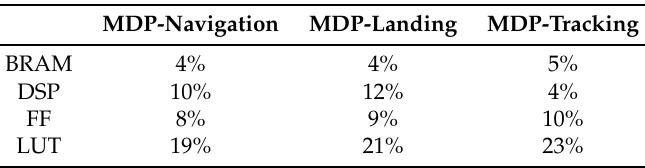
Table 10. FPGA resources for the MDP